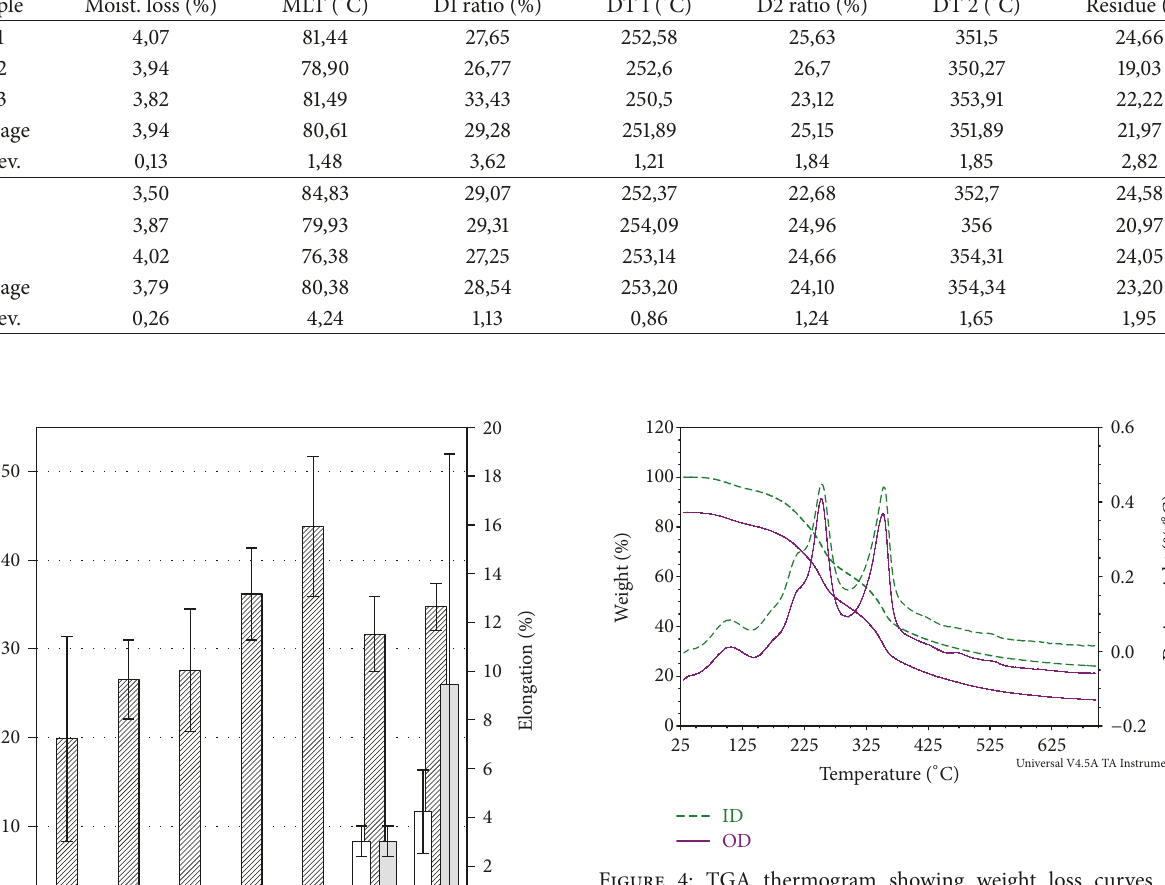
Figure 4: TGA thermogram showing weight loss curves and derivative weight curves of OD and ID